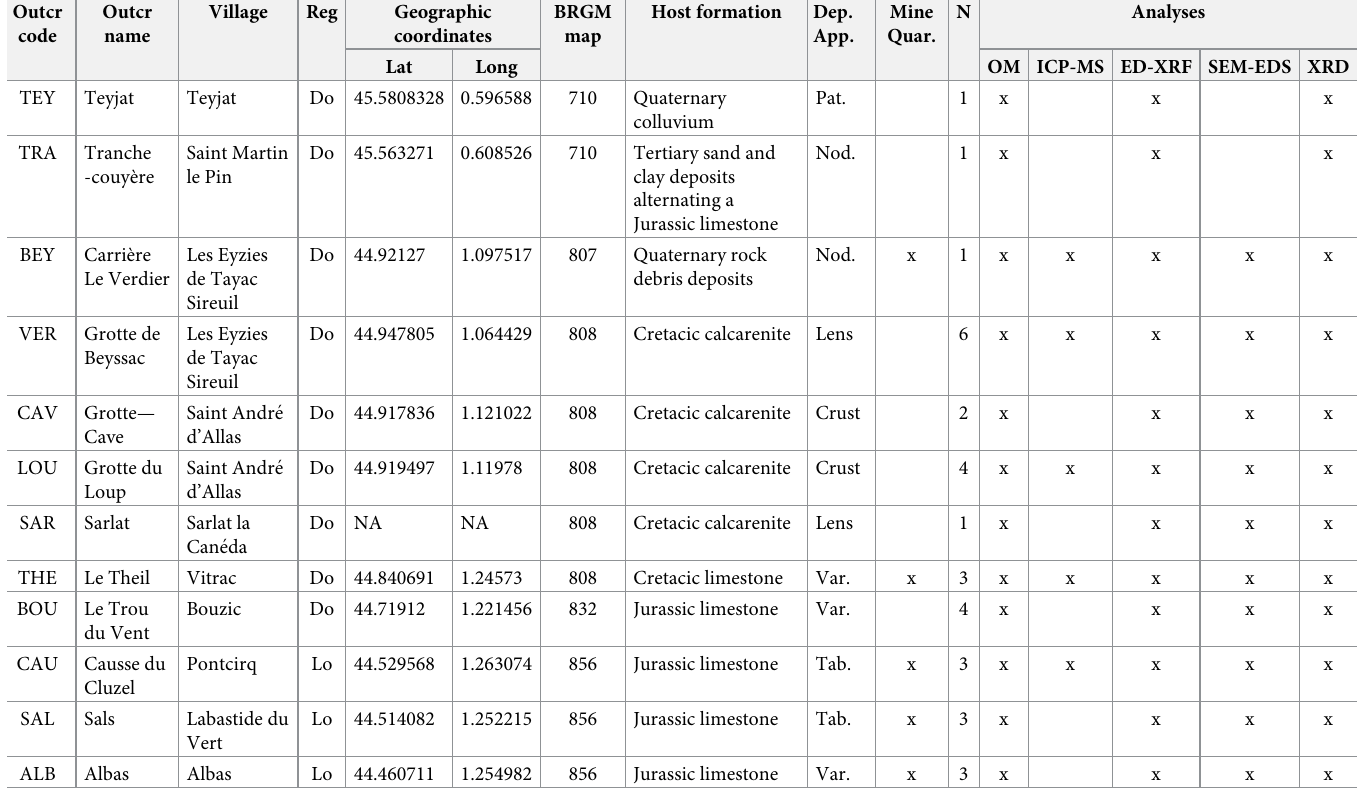
Table 2. Information on Mn-rich outcrops analysed in this